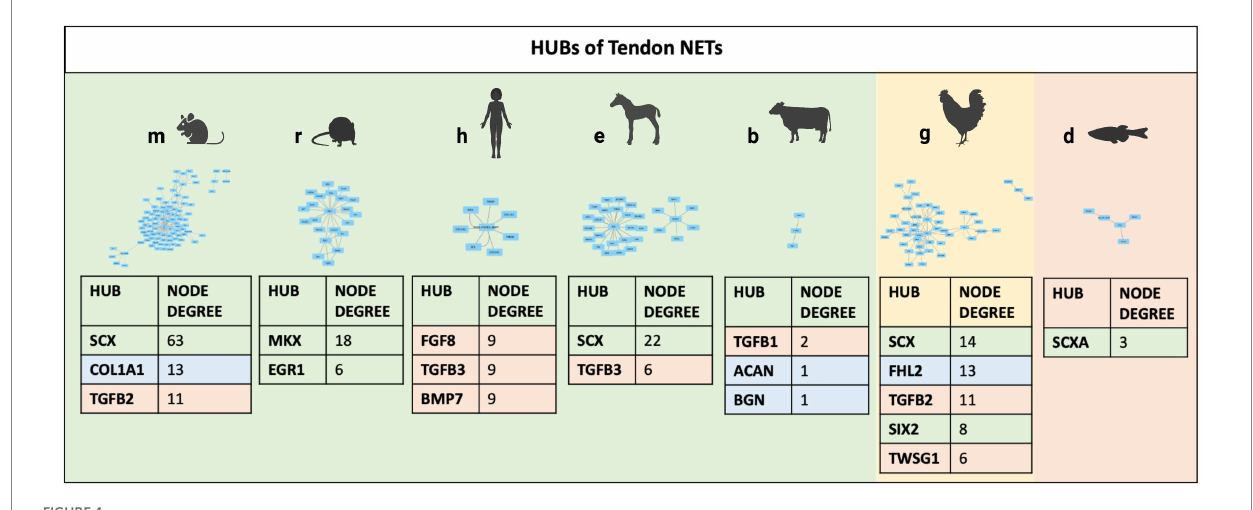
FIGURE 4 Hubs of TendonNETs. Hubs were identified and ranked based on the hub node degree value. The different colors of the hub molecules allow to identify the signaling layer of pertinence. In orange were reported nodes of the upstream layer; in green nodes of the TF layer, and in light blue nodes of the downstream layer.